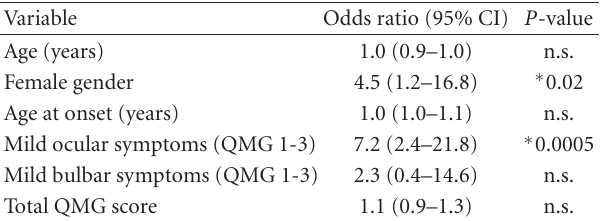
Table 2: Influences of clinical factors on headache associated with